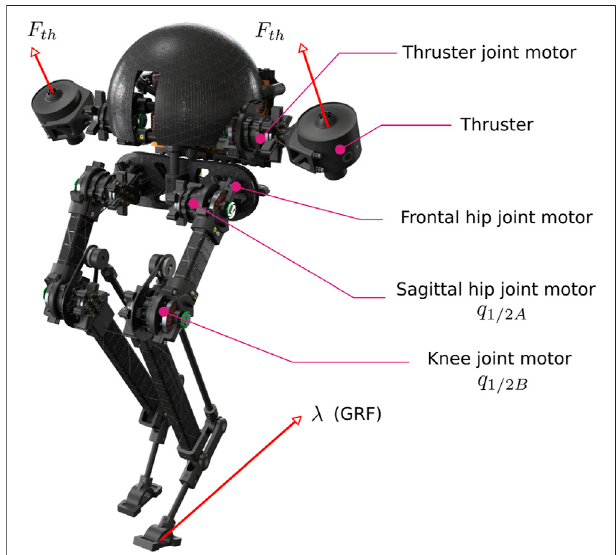
FIGURE 1 | Illustration of Harpy ’ s CAD model. Harpy is a bipedal robot with a pair of thrusters and is being developed by the authors to study robust, ef fi cient and agile thruster-assisted legged